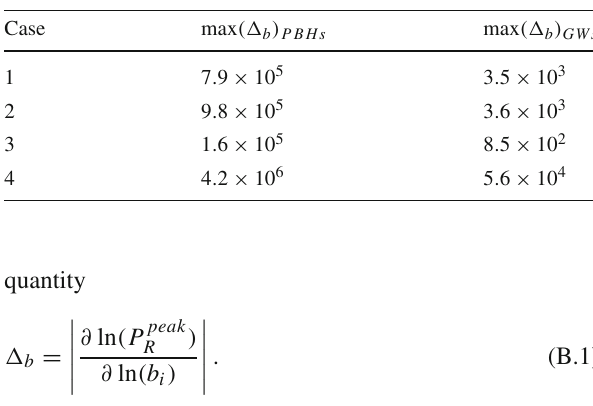
Fig. 7 The level of fine-tuning for the case (3.7) Table 3 The maximum value for (cid:18) b for the cases in Eqs. (3.2), (3.5), (3.7) and (3.9) respectively. The abundances of PBHs are adopted by [21,22]. Details given are in main